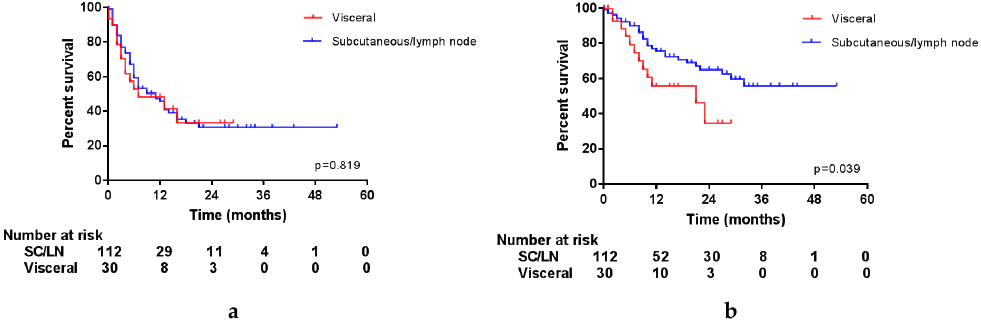
Figure 3. Survival per location of surgery. ( a ) Progression-free survival; ( b ) overall survival.